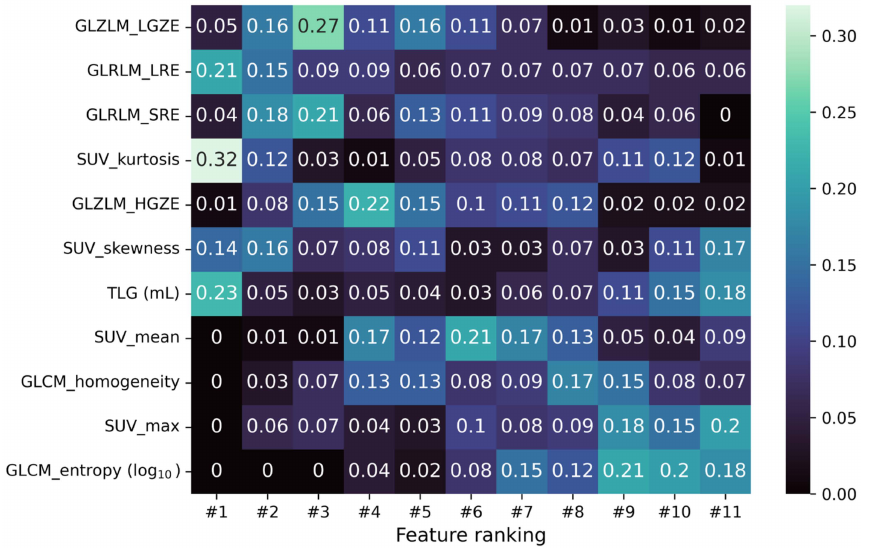
Figure 2. Matrix N features × N features reporting the fraction of times the i -feature ends up in the j -position of the ranking obtained from the RFE algorithm during a 100-iterated bootstrap technique on the logistic regression